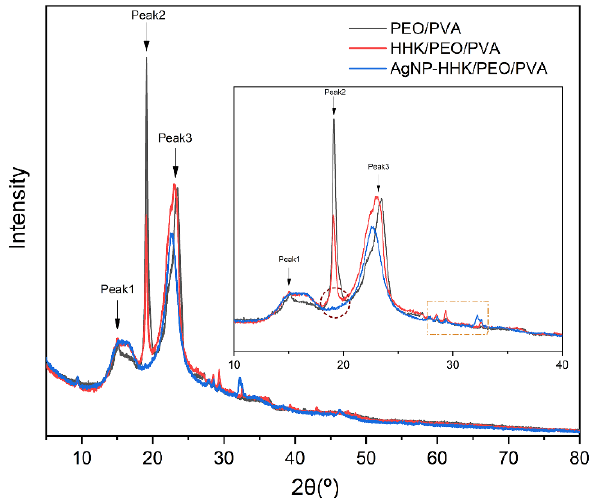
Figure 6. X-ray diffraction patterns of the PEO/PVA, HHK/PEO/PVA and AgNP-HHK/PEO/PVA nanofibrous